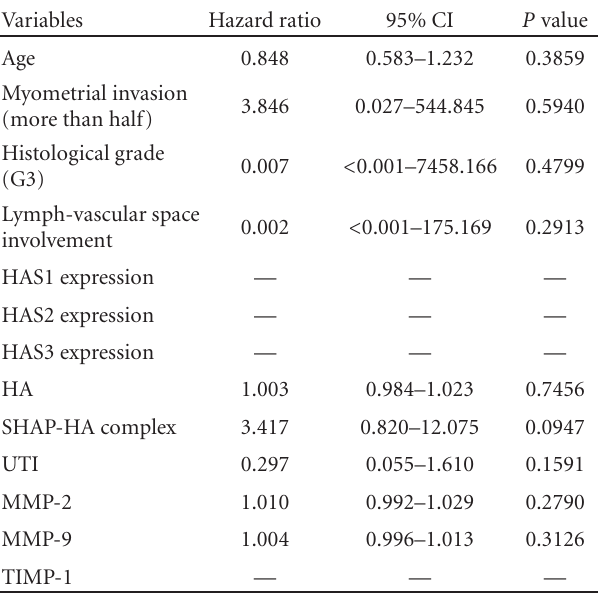
Table 7: Hazard ratios for overall survival with 95%CIs adjusted for HAS, HA, SHAP-HA complex, UTI, MMP-2, MMP-9, TIMP-1, and the clinicopathological manifestations in patients with endometrial